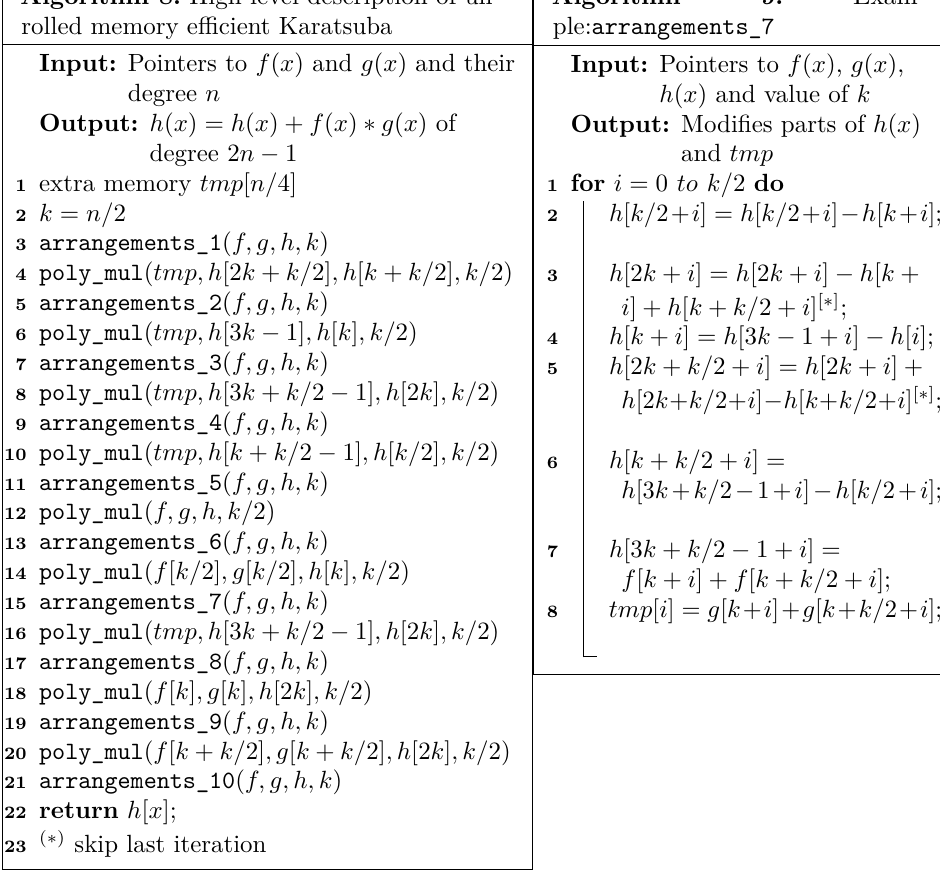
Algorithm 8: High-level description of un- rolled memory efficient